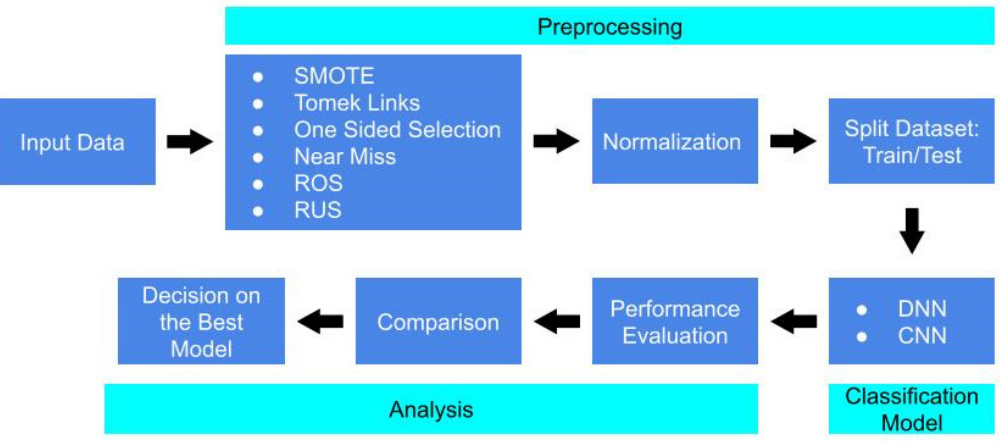
Figure 2. The framework overview of our proposed methodology in this study.